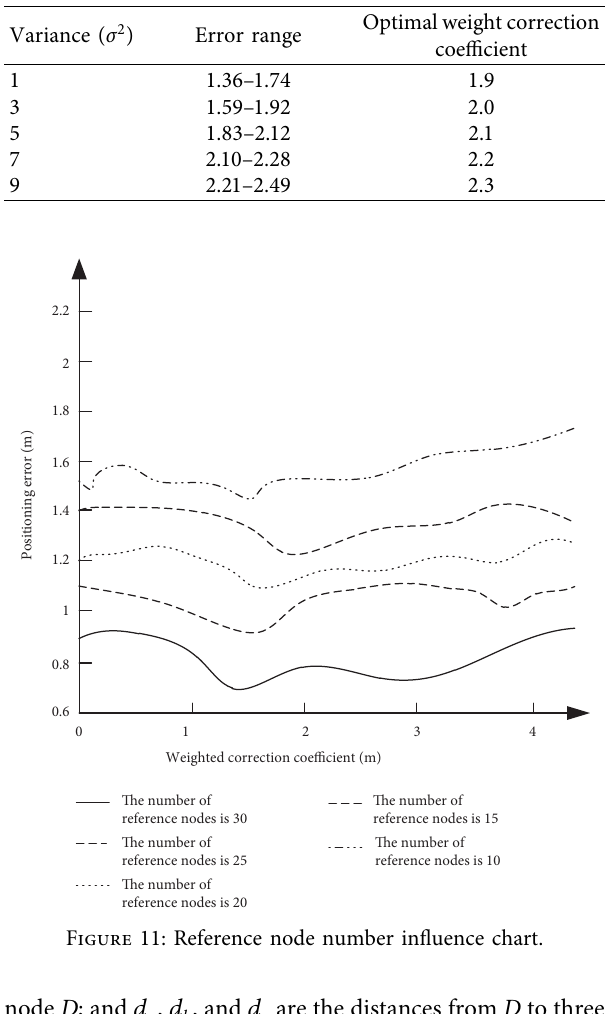
Table 3: Correction results of static weight correction coefficient under the influence of air interference intensity.